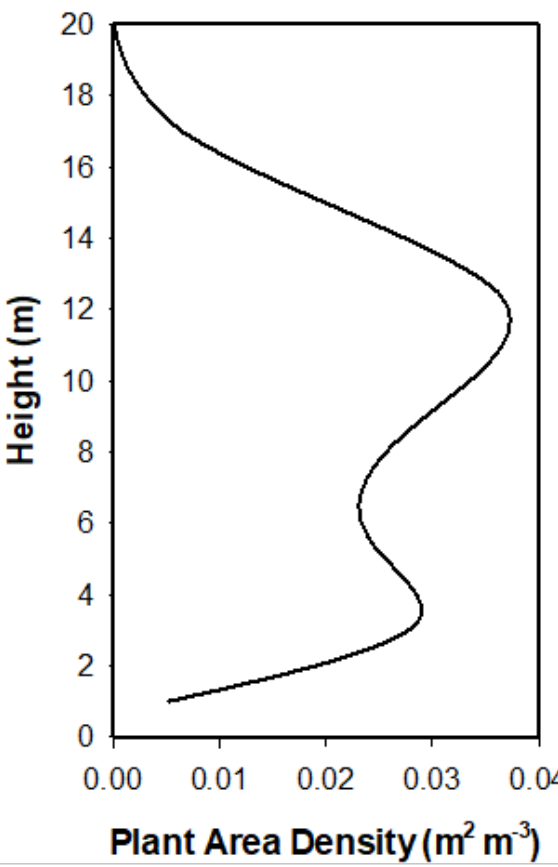
Figure 2. Average plant-area-density (m 2 m −3 ) profile in the burn unit for the 13 March 2019 SERDP management-scale prescribed fire experiment based on aerial Lidar measurements of the vegetation